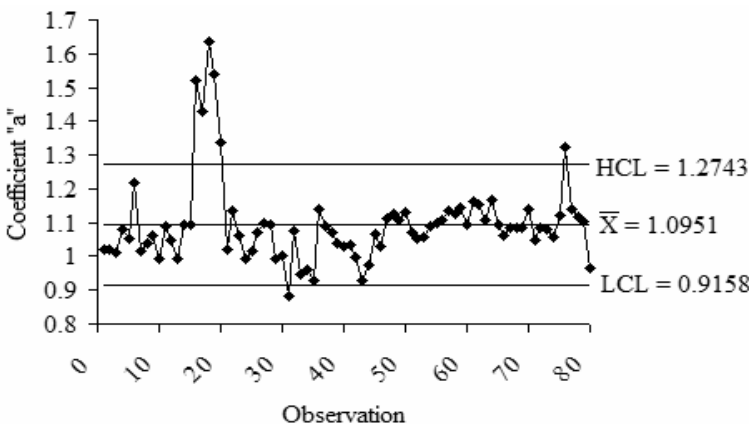
Figure 2. Statistical quality control for the linear